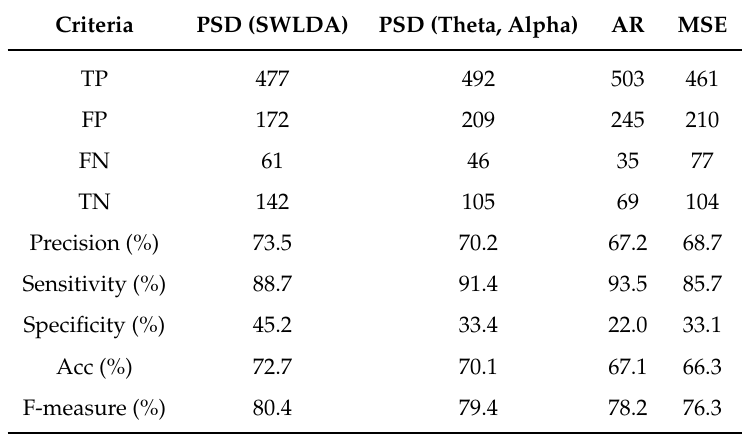
Table 4. Performance summary of alert vs. drowsy classifications when the thresholds for the two classes were set to 3 and